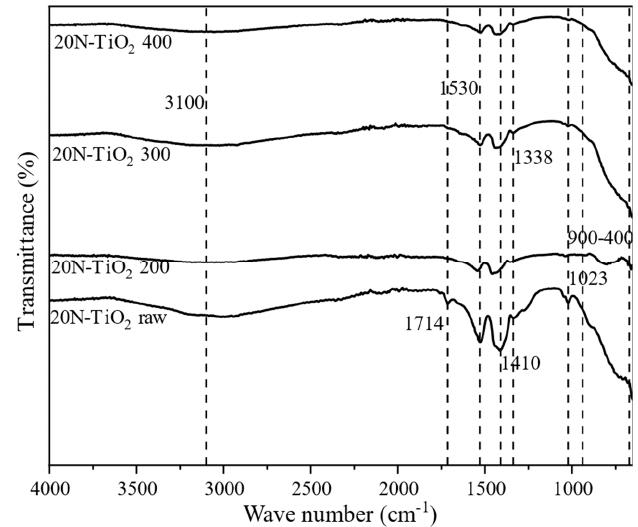
Figure 4. Fourier-transform infrared spectroscopy (FTIR) spectra of as-synthesized and calcined 20N–TiO 2 photocatalysts.